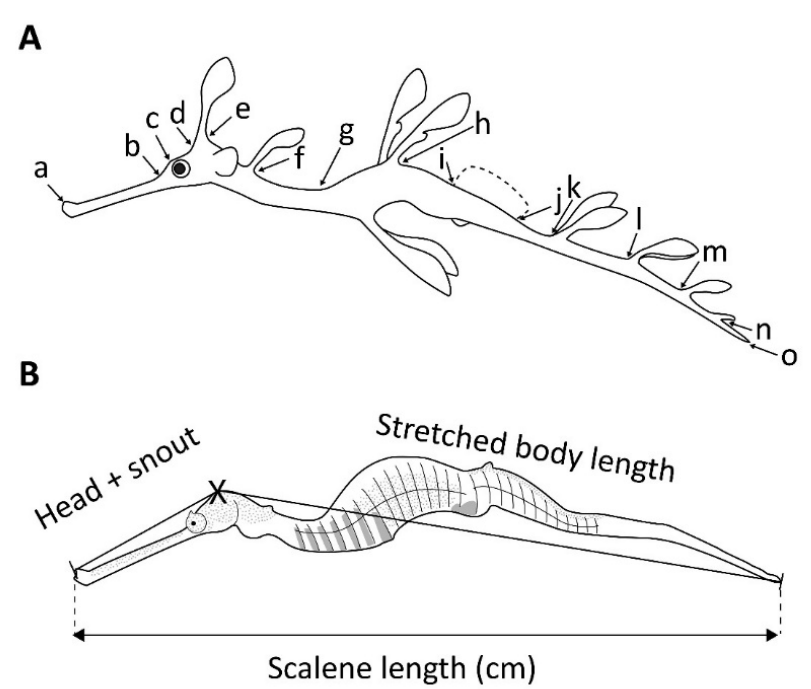
Figure 2. Approaches for defining the ‘length’ of seadragons: ( A ), modified from Figure 1 of Forsgren and Lowe [10], identifies the successive 14 body segments (a–b; b–c; etc. until n–o) whose lengths are added to obtain what may be called ‘cumulative length’ (CL); ( B ) documents a practical ‘scalene length’ (ScL), so named as it refers to the longest side of a scalene triangle, whose other sides are formed by the head and the stretched body.